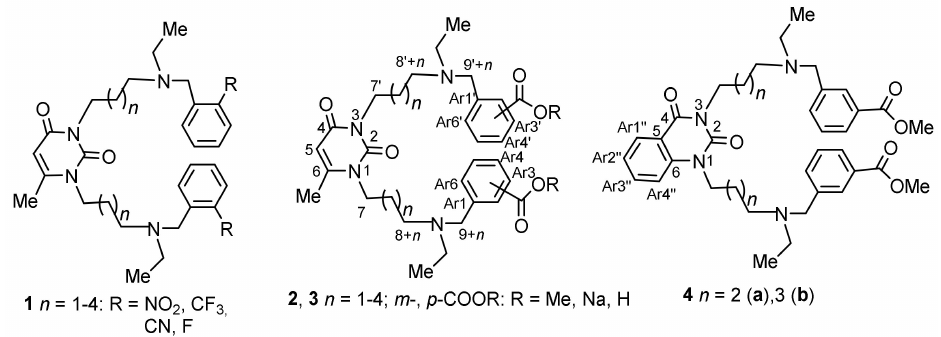
Figure 1. Structures of previously reported AChE inhibitors 1a-c with 6-methyluracil, nitro tri- fluoromethyl and nitrile moieties [13,14] and the herein–reported AChE inhibitors 2 , 3 and 4 with 6-methyluracil, quinazoline-2,4-dione and benzoate moieties. Numbering of atoms of title compounds atoms is shown, and this numbering is used when describing NMR spectra of the